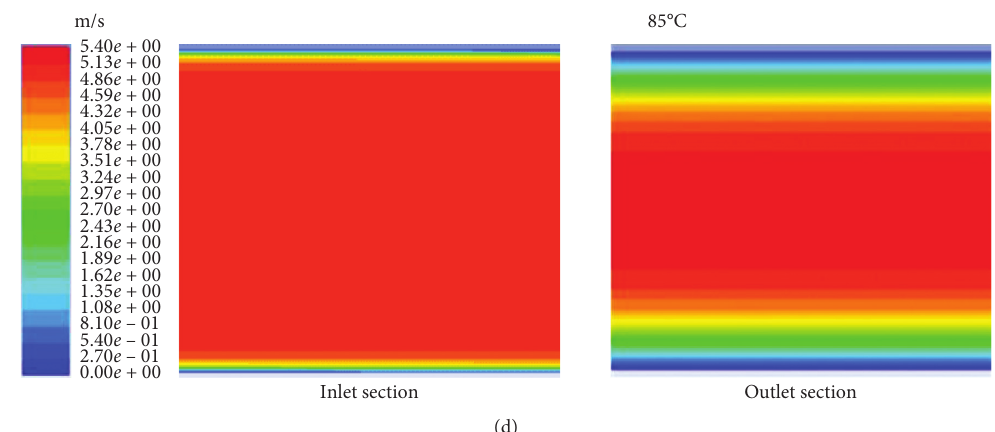
Figure 8: Vectors of velocity at inlet and outlet section at 25 ° C–85 ° C.